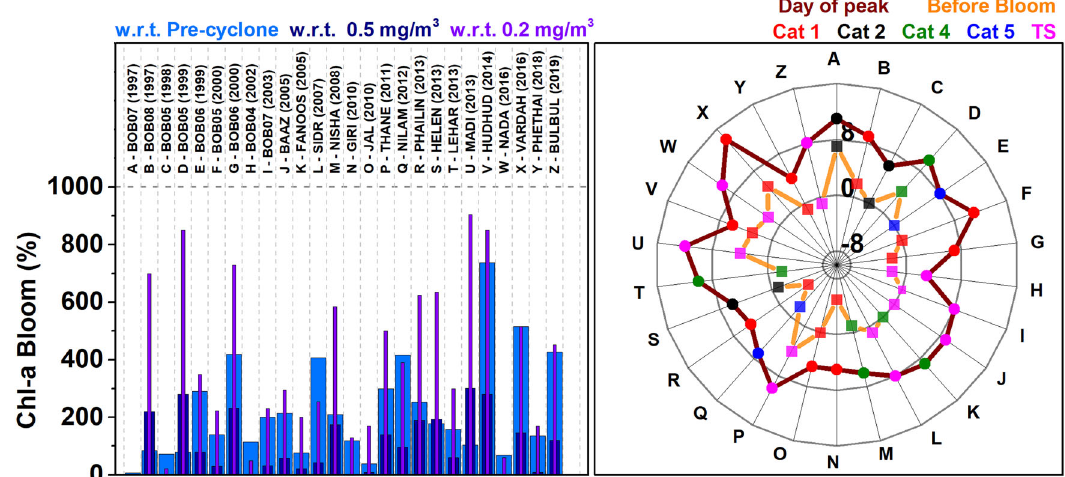
Fig. 7 The change in cyclone-induced bloom and time lag. Left: with respect to pre-cyclone Chl-a values (blue), 0.5 mg/m 3 (dark blue) and 0.2 mg/m 3 (magenta) for the post-monsoon cyclones in Bay of Bengal (BoB). Right: The time lag in days in cyclone-induced Chl-a bloom with respect to the pre-cyclone Chl-a (blue histograms, left) for the post-monsoon cyclones of